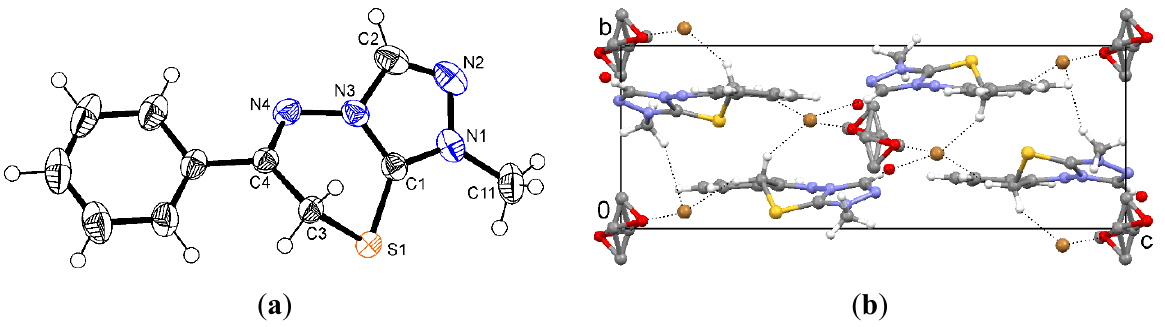
Figure 3. ( a ) O RTEP plot and atom numbering scheme of the cation; ( b ) packing and hydrogen bonding of 2 .